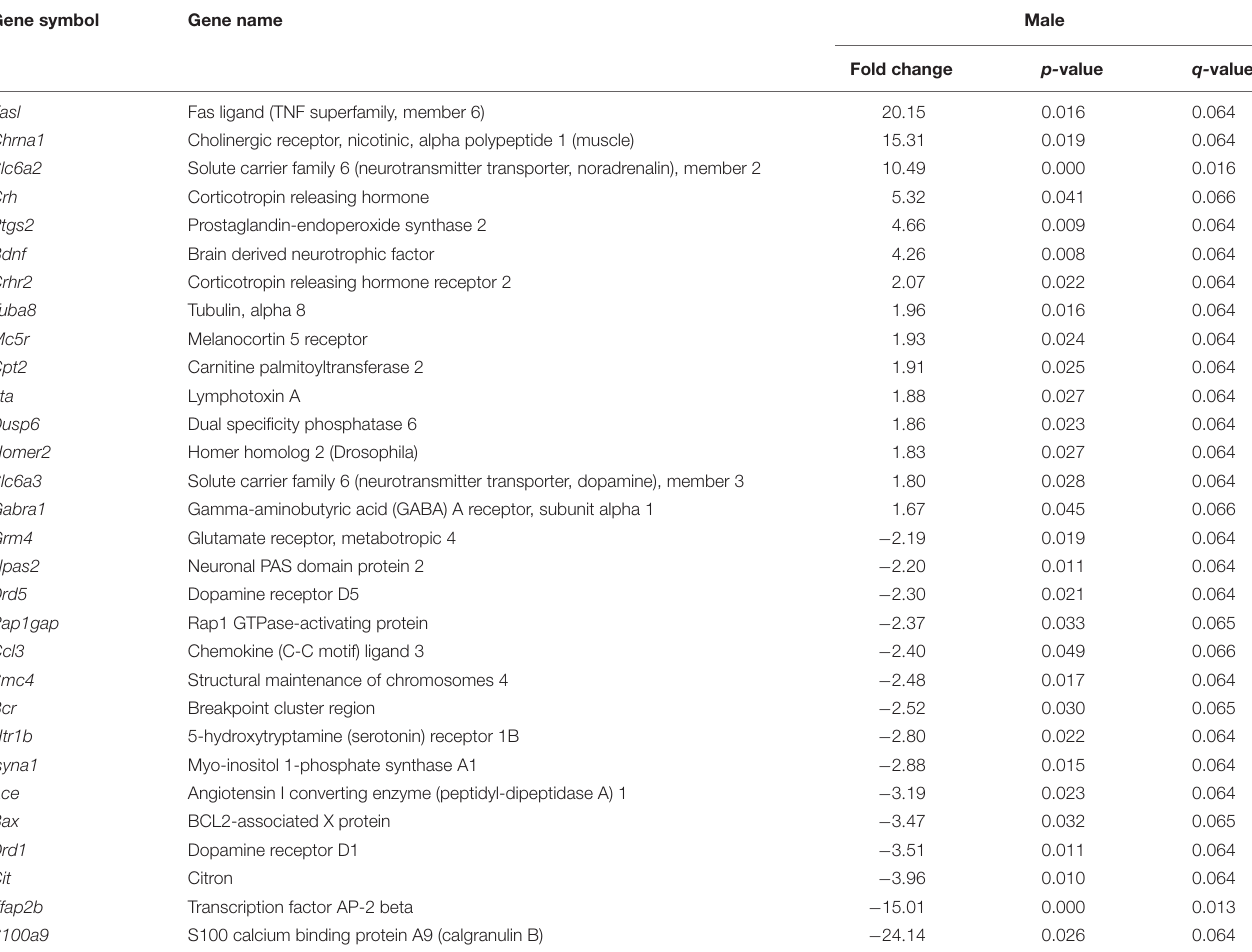
TABLE 4 | Top 30 genes significantly regulated by binge drinking in male nucleus